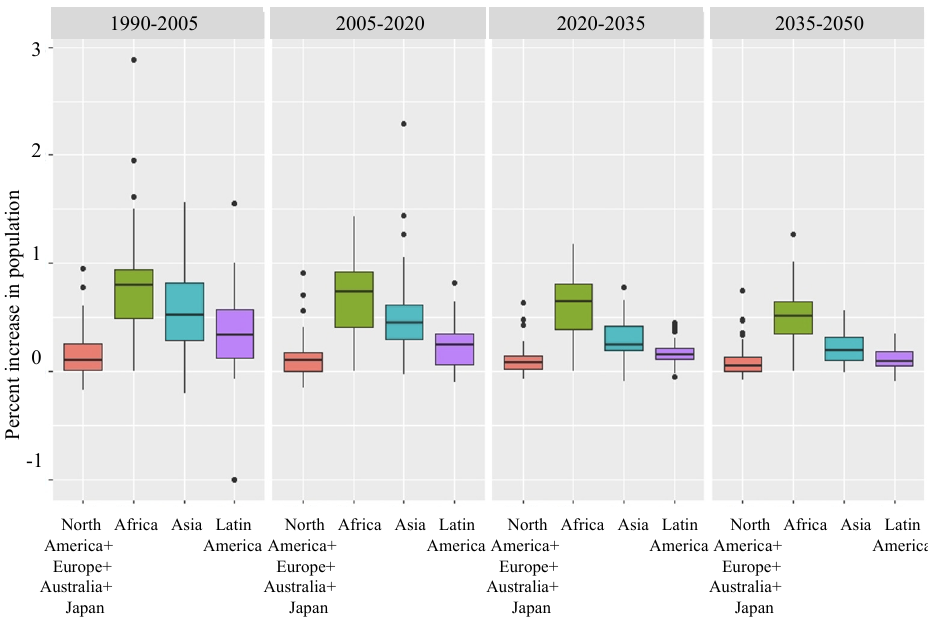
Figure 1. Inter- regional comparison of urban population growth, 1990–2005, 2005–2020, 2020–2035, 2035–2050.